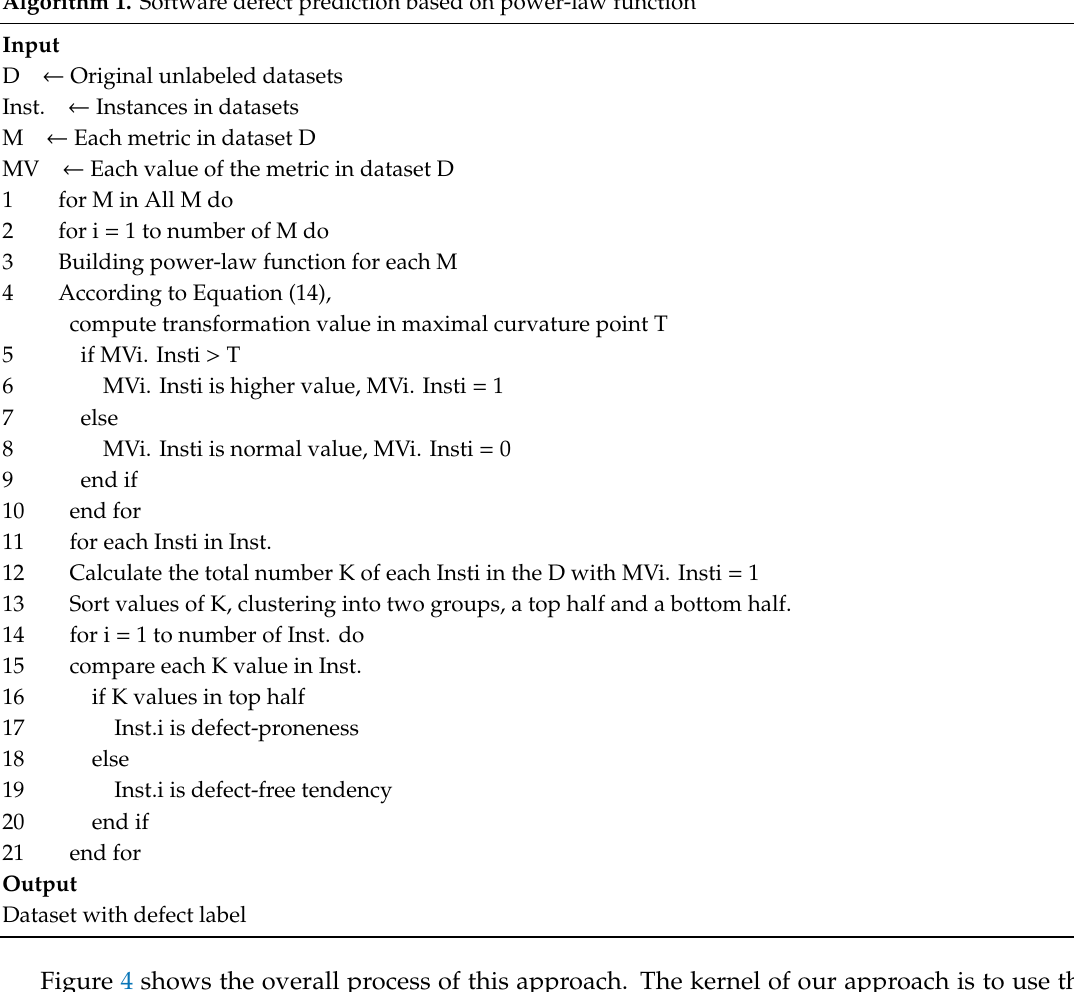
Algorithm 1. Software defect prediction based on power-law function